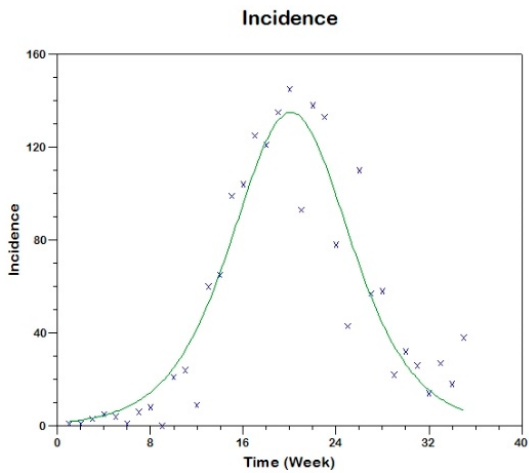
Figure 12 . Model fit to the reported incidence of the first outbreak in Tolima-Colombia using Method 2.